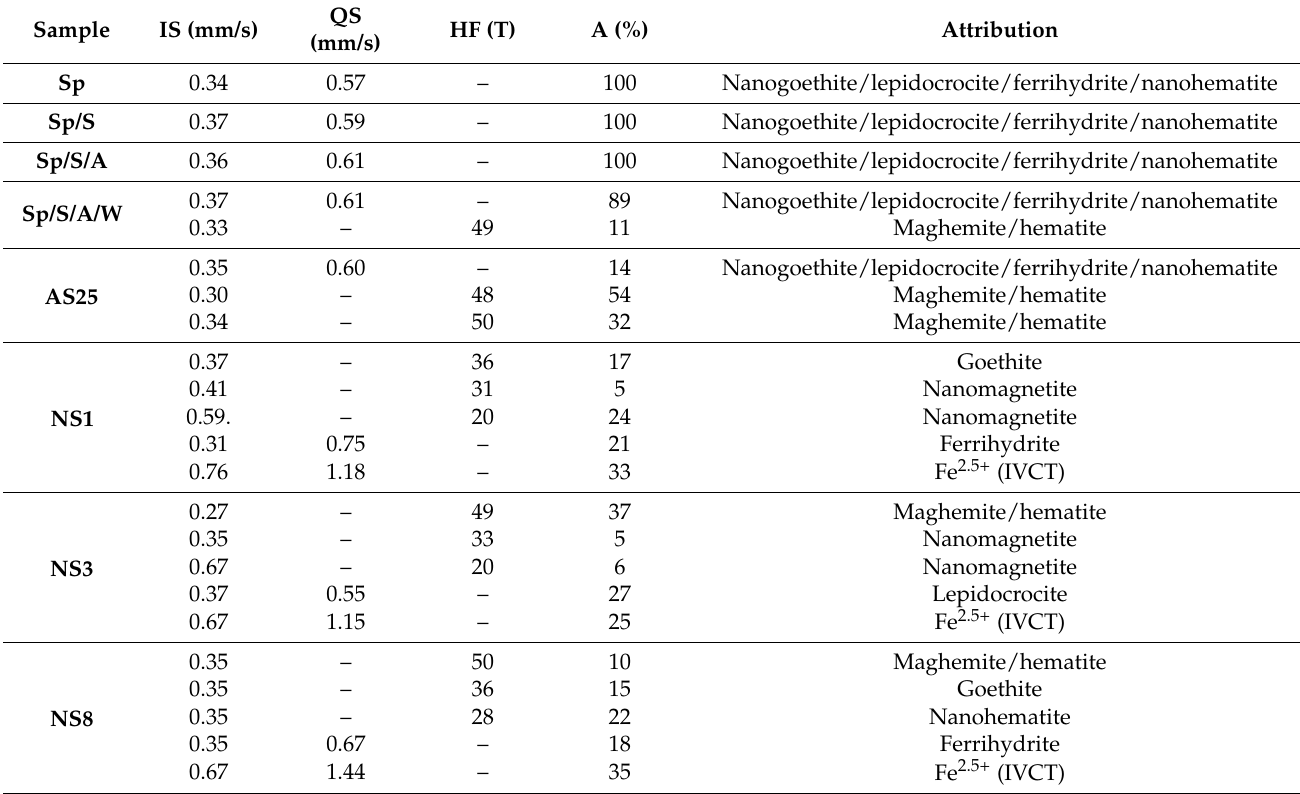
Table 3. 57 Fe Mössbauer parameters relative to the studied archeological and artificially stained marble